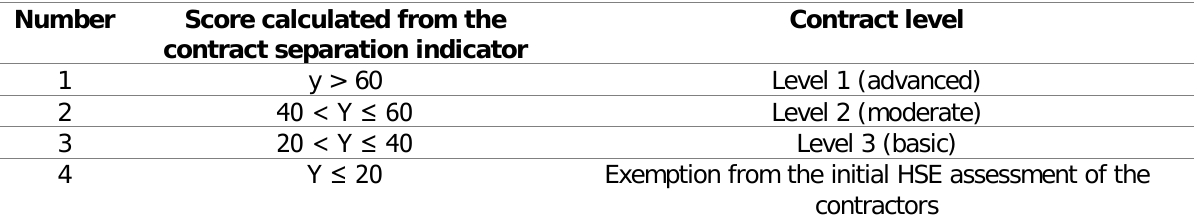
Table 6. Contract